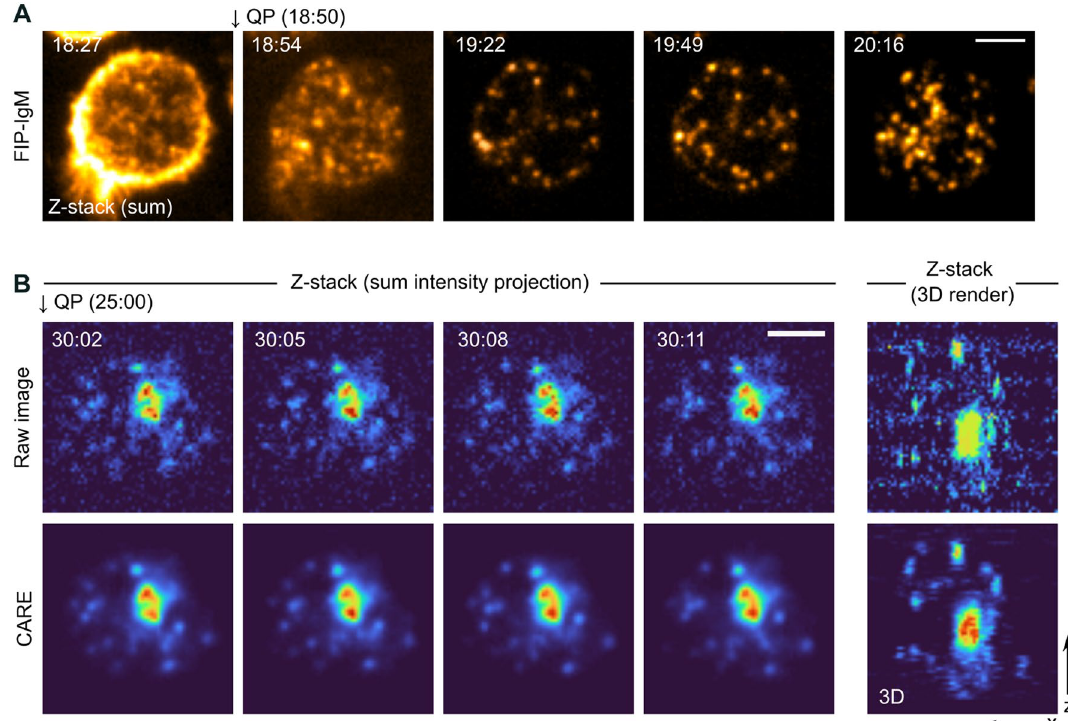
Figure 5. 4D live imaging of antigen in B cells. ( A ) B cells adhering to fibronectin were engaged with ATTO- FIP-IgM on ice. Cells were transferred to 37 °C to trigger endocytosis and the recording was started. QP was added to the cells at indicated time points (arrows) after activation without interrupting image acquisition. Images were acquired using a SDCM (49 planes, one stack every 27 s). Scale bar: 5 µm. LUT Hot Yellow. ( B ) Short acquisition time images (raw image) were acquired using a SDCM (49 planes, one stack every 3.7 s) and restored using CARE. Time in minutes after triggering endocytosis is indicated in the top-left corner. Scale bar: 5 µm. LUT